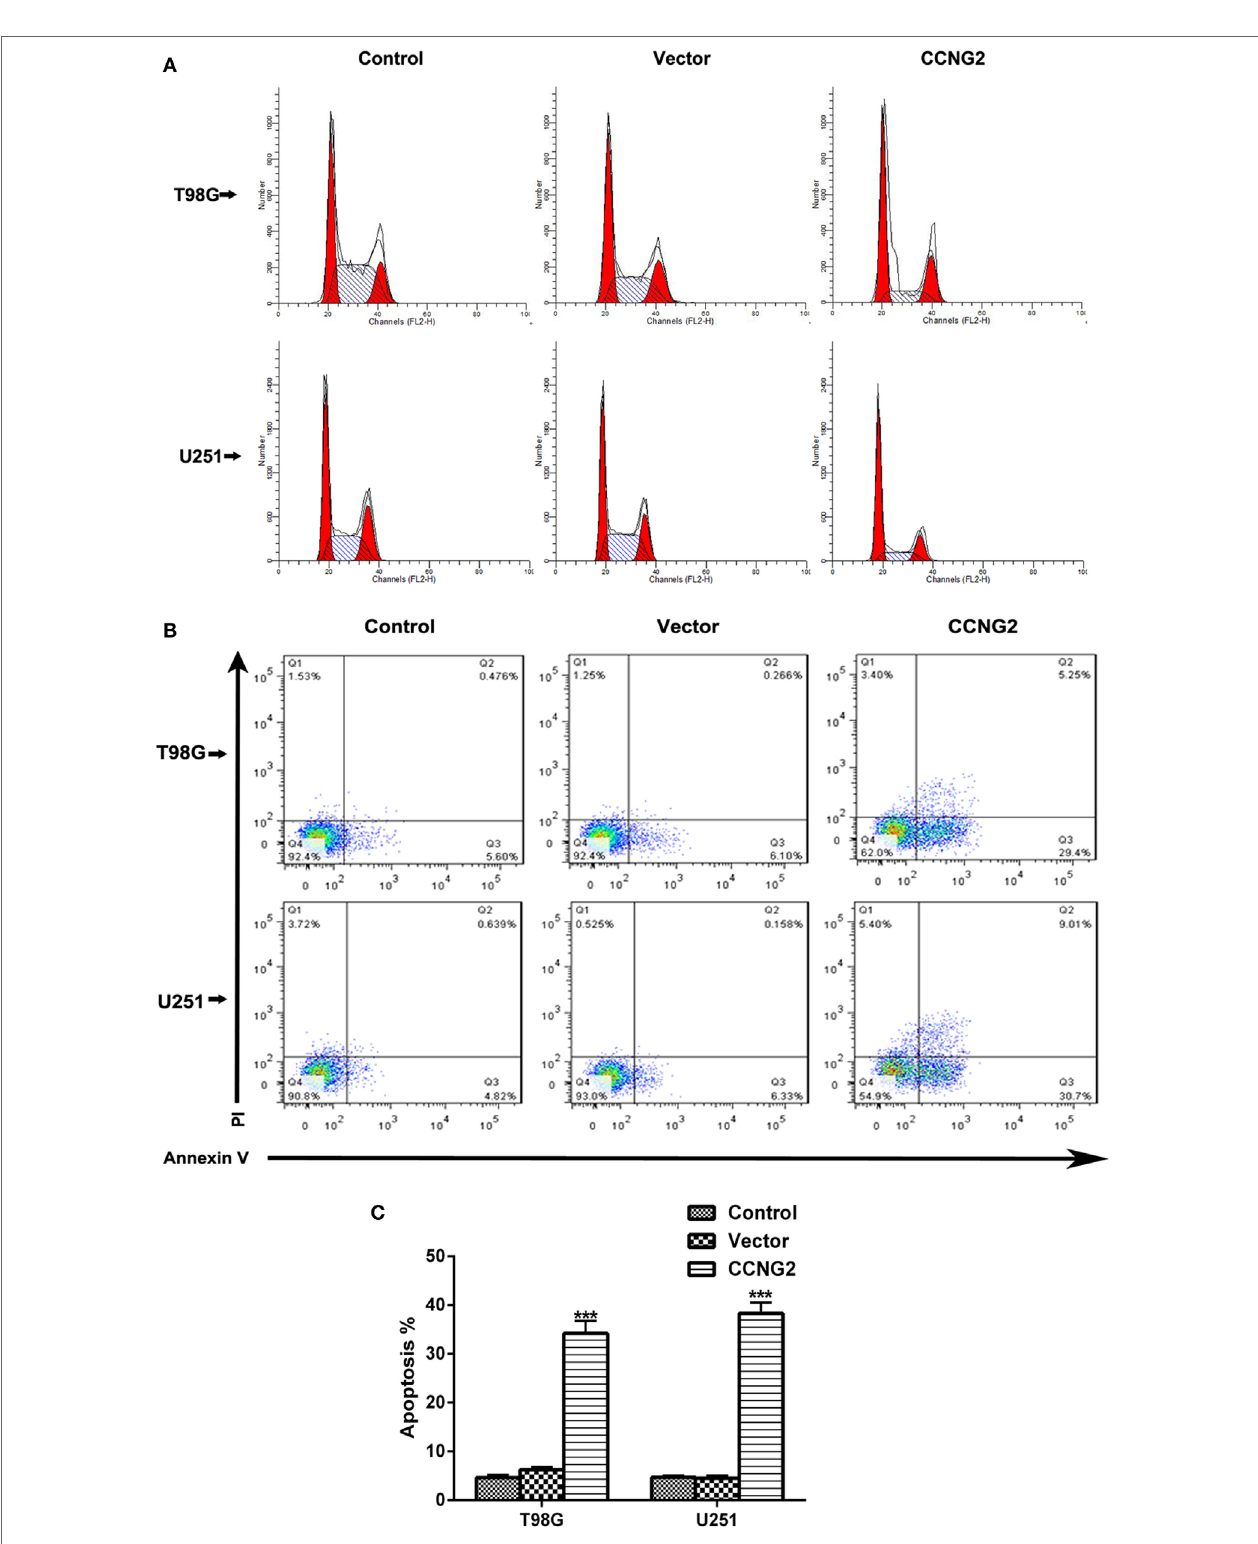
FigUre 3 | Effects of CCNG2 overexpression on cell apoptosis and cell cycle progression. (a) Propidium iodide staining and flow cytometry were used to examine the effect of CCNG2 overexpression on cell cycle progression in T98G and U251 cells. The quantitative results are summarized in Tables 3 and 4 . (b,c) Analysis of apoptosis rates by flow cytometry in T98G and U251 control cells or cells transfected with CCNG2 or vector. Data were expressed as means ± SEM ( n = 3). *** P < 0.001 by the unpaired two-tailed Student’s t